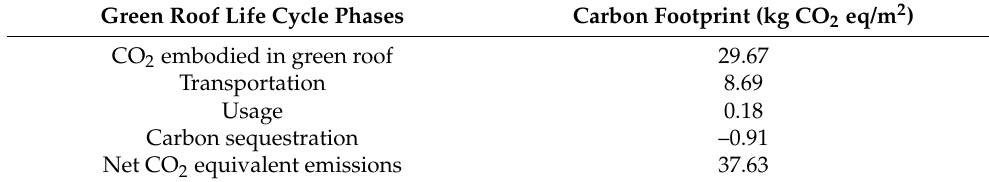
Table A1. Green roof life cycle